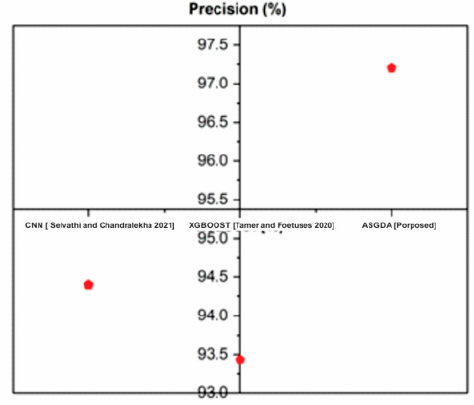
Figure 8. Comparison of accuracy with the traditional and proposed method [42,43].